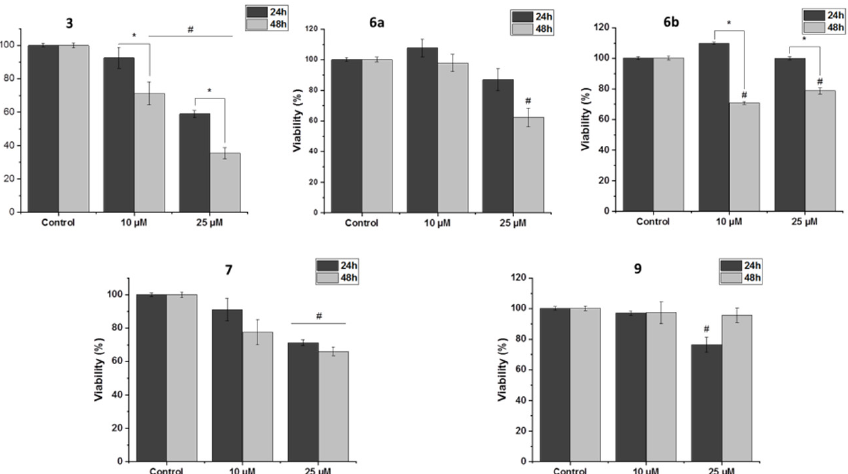
Figure 4. The effects of compounds 3 , 6a, 6b , 7 and 9 on the viability of MDA-MB-231 cells, evaluated by MTT assay. Cells were treated with 10 μ M and 25 μ M for 24 h or 48 h. Data are shown as mean ± SEM of at least three separate experiments. * p < 0.05 compared with the untreated cells. #: p < 0.05 compared with the cells treated with 10 μ M solutions